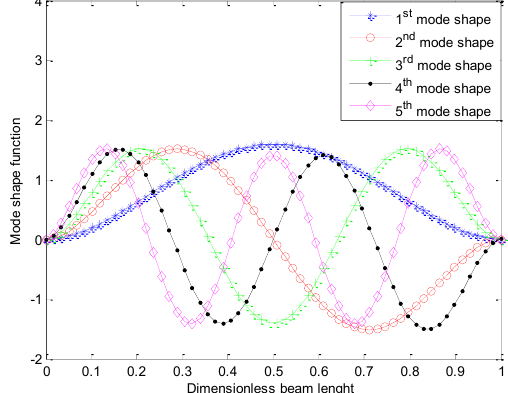
Figure 5: The first five normalized mode shaped of the beam